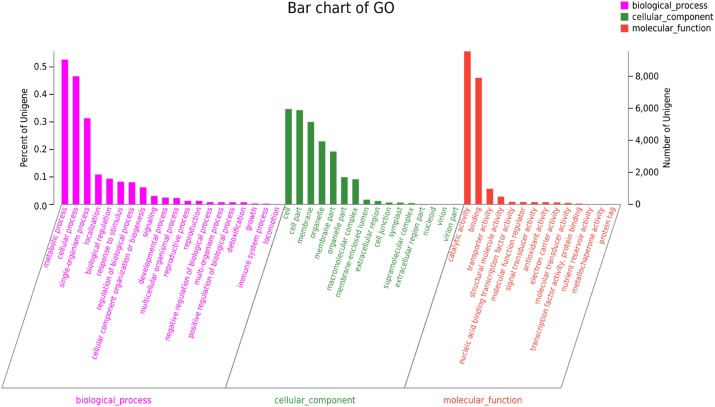
GO classification of the C. chago transcriptome.